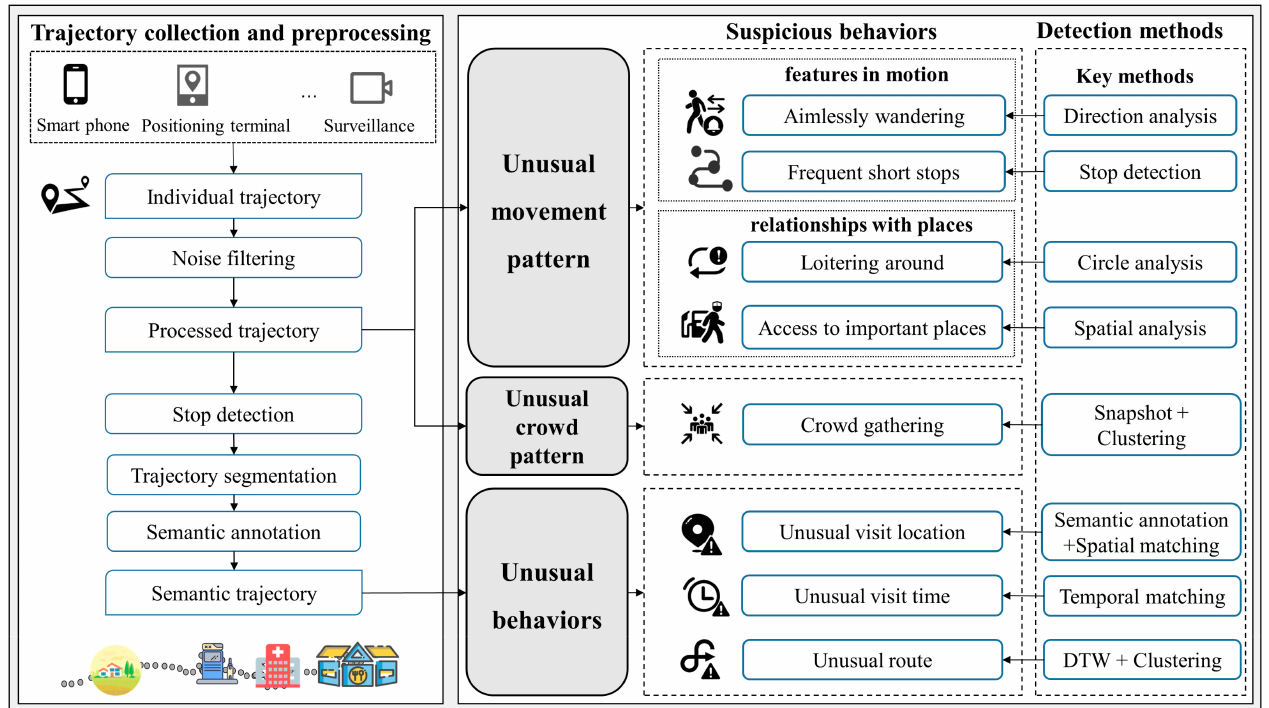
Figure 1. Flowchart of the proposed method for suspicious behavior detection from the trajec- tory